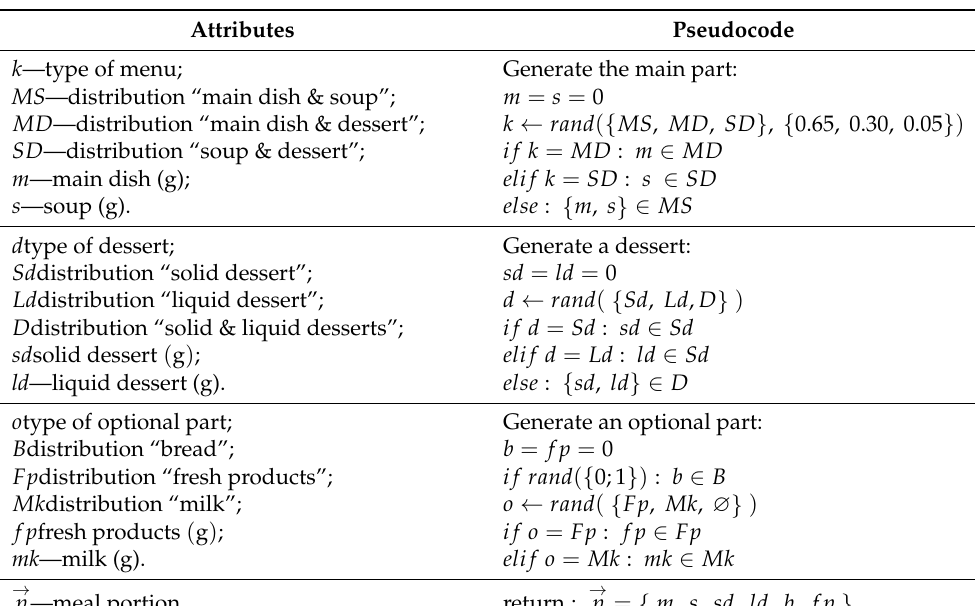
Table 6. Pseudocode for week menu